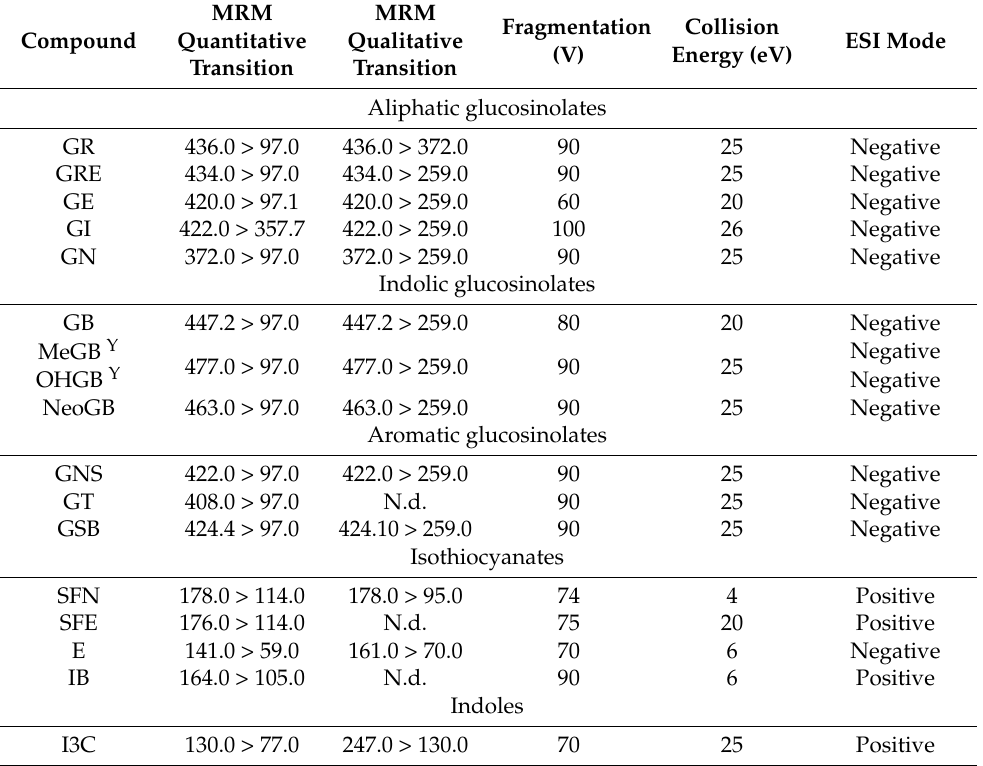
178.0 > 114.0 141.0 > 59.0 161.0 > 70.0 164.0 > 105.0 130.0 > 77.0 247.0 >